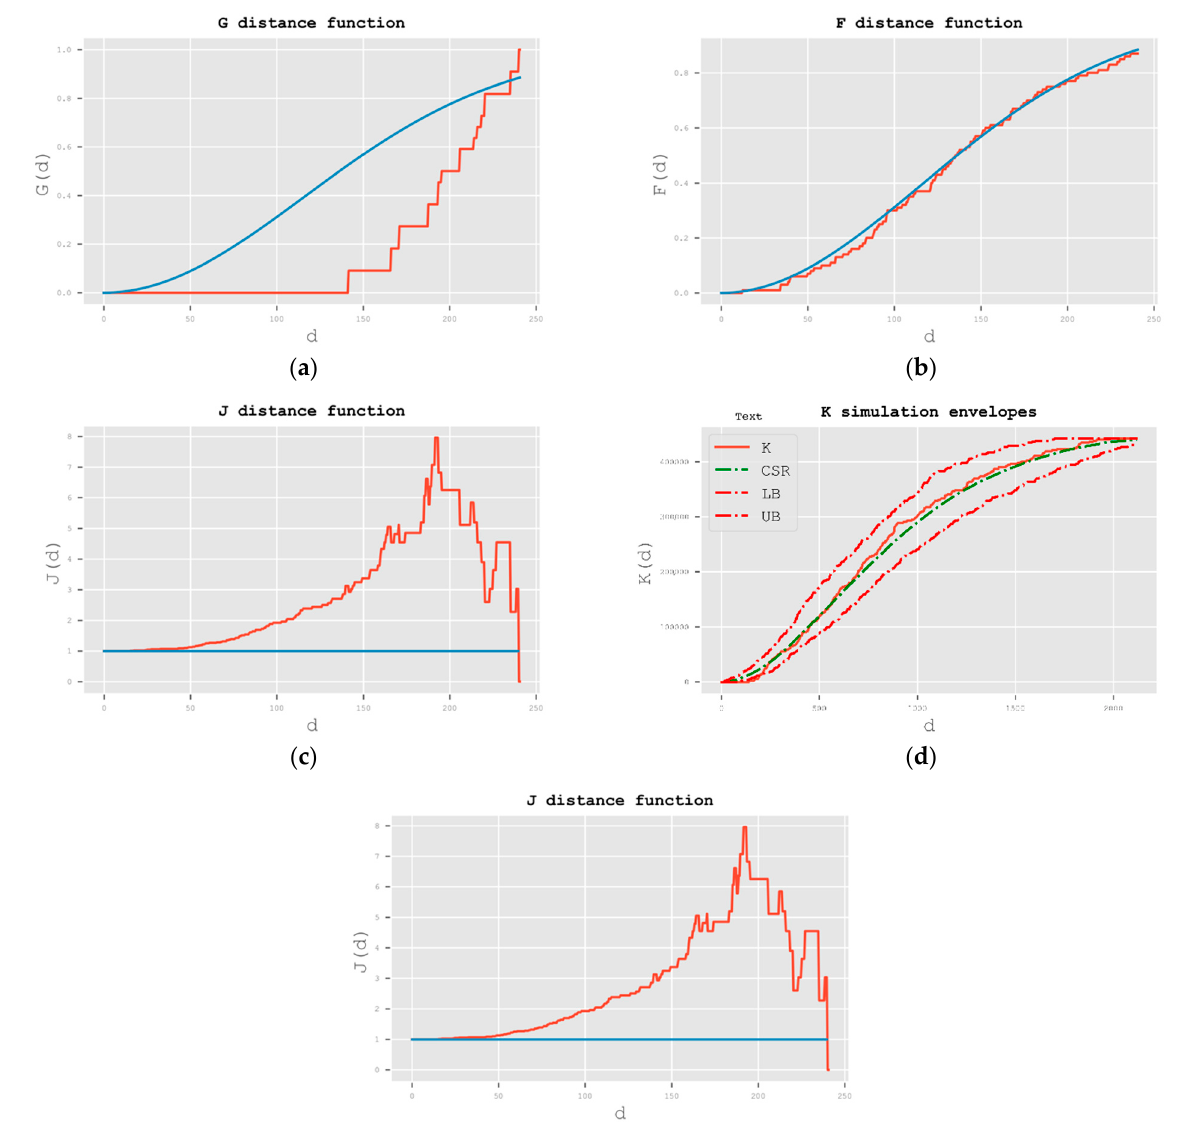
Figure 4. ( a ) G function, ( b ) F function, ( c ) J function, ( d ) K function (with envelope) and ( e ) L function with envelope.